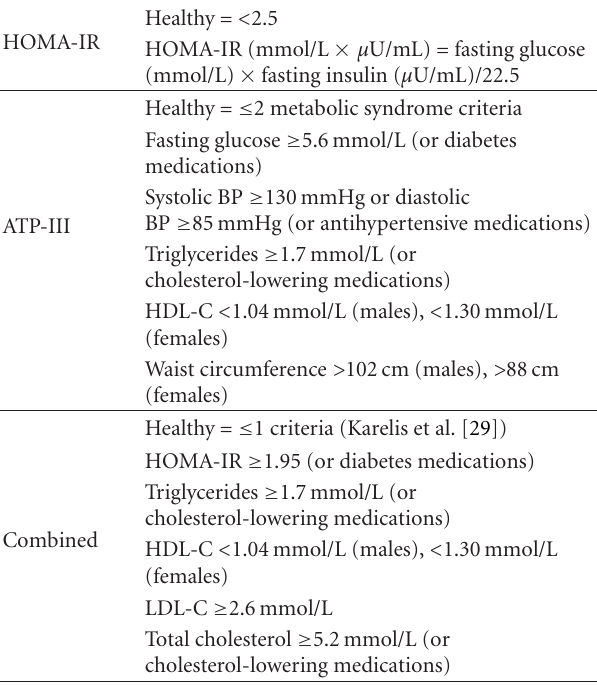
Table 1: Definitions of metabolic